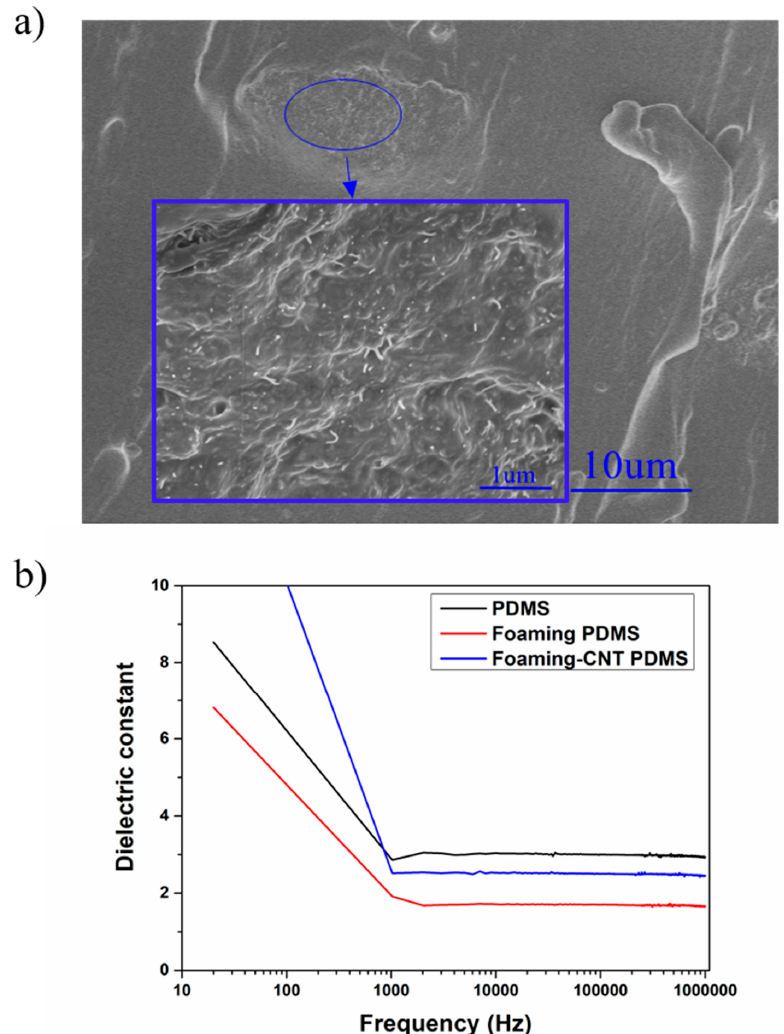
Figure 5. ( a ) SEM image of CNT-doped porous PDMS sample; ( b ) dielectric constants as a function of frequency for TENG with pure PDMS, TENG with undoped porous PDMS, and TENG with CNT-doped porous PDMS.